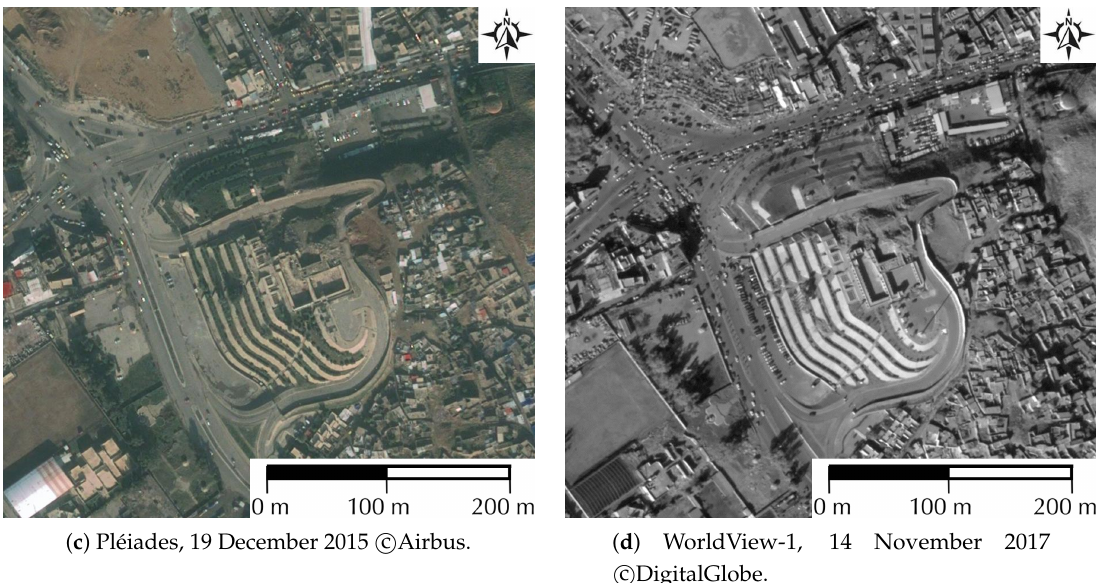
Figure 17. Satellite imagery of the Nebi Yunus Mosque